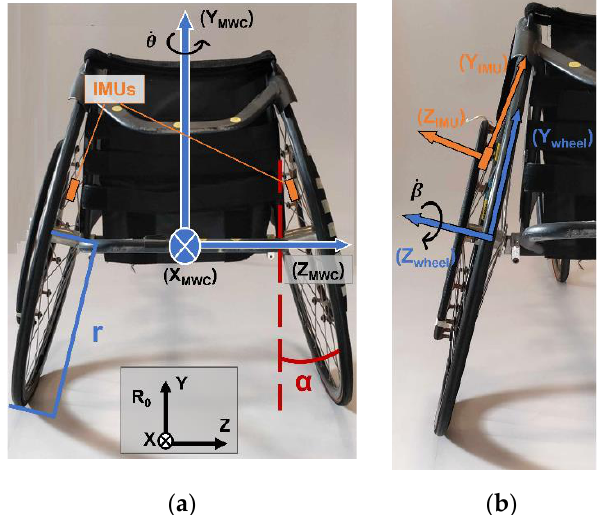
Figure 1. ( a ) Back view of a wheelchair illustrating the placement of the IMUs, wheelchair reference frame used as well as camber (α), and rear wheel radius (r); ( b ) Illustration of the tilt of an IMU placed on the spokes of a wheelchair.